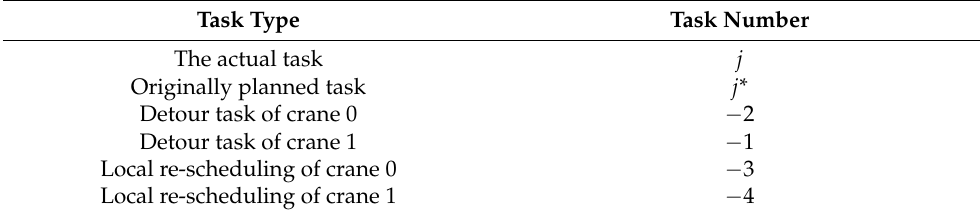
Table 4. Task type and its number.